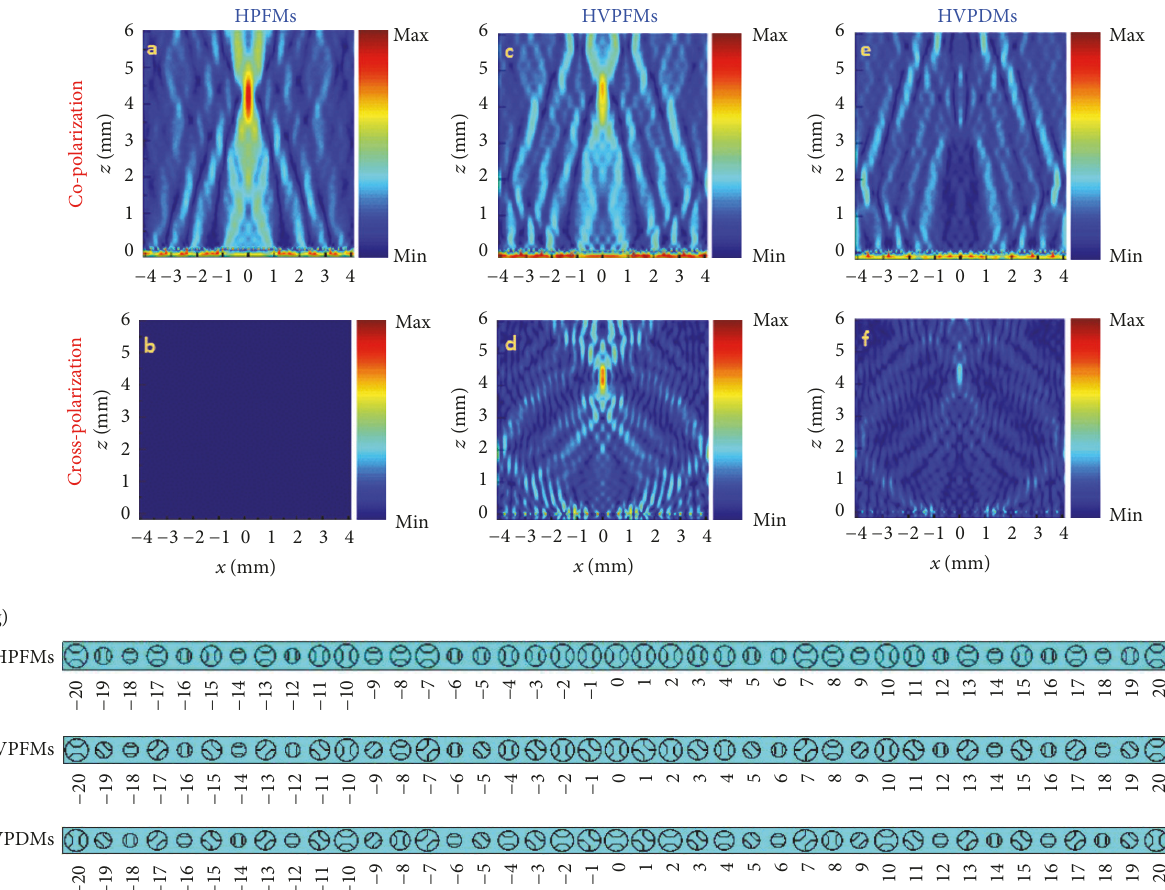
Figure 3: (a–f) The electric field intensity distribution of copolarized transmitted wave and cross-polarized transmitted wave at 0.68 THz for HPFMs, HVPFMs, and HVPDMs, respectively. (g) Structures of these three